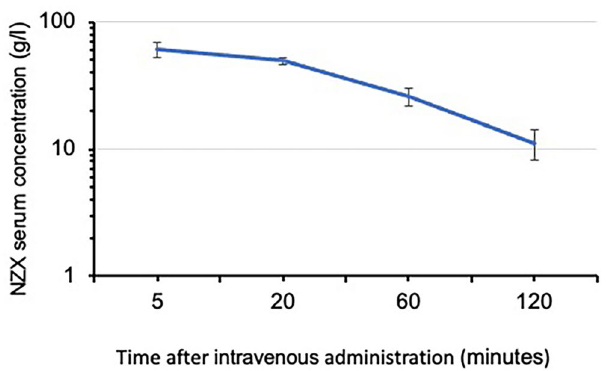
Figure 3. Pharmacokinetic studies of NZX. Mice received a single dose of NZX 33 mg/kg through intra-venous route (n = 3 at each timepoint). The maximum observed mean concentrations for intravenous dosing was 61 mg/l after 5 min and the terminal half-life was estimated to 42 (± 5.6) min. After 240 min the NZX was not detected in the